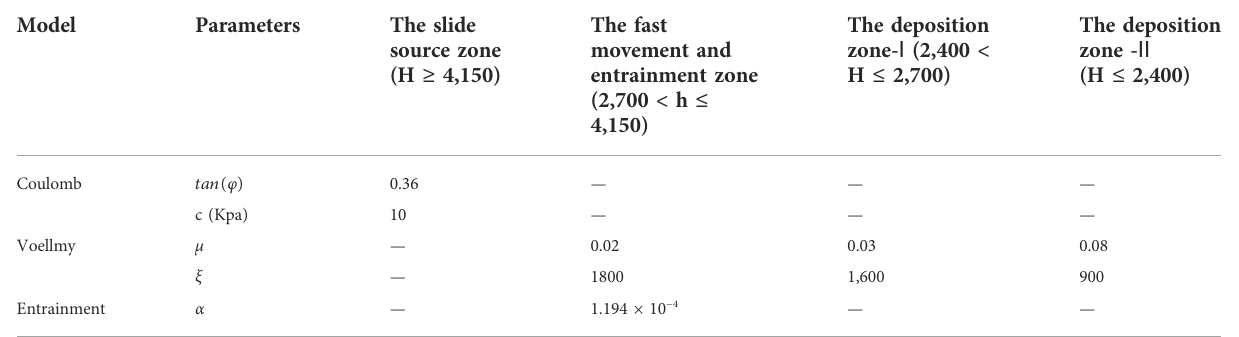
TABLE 1 Model and simulation parameters.